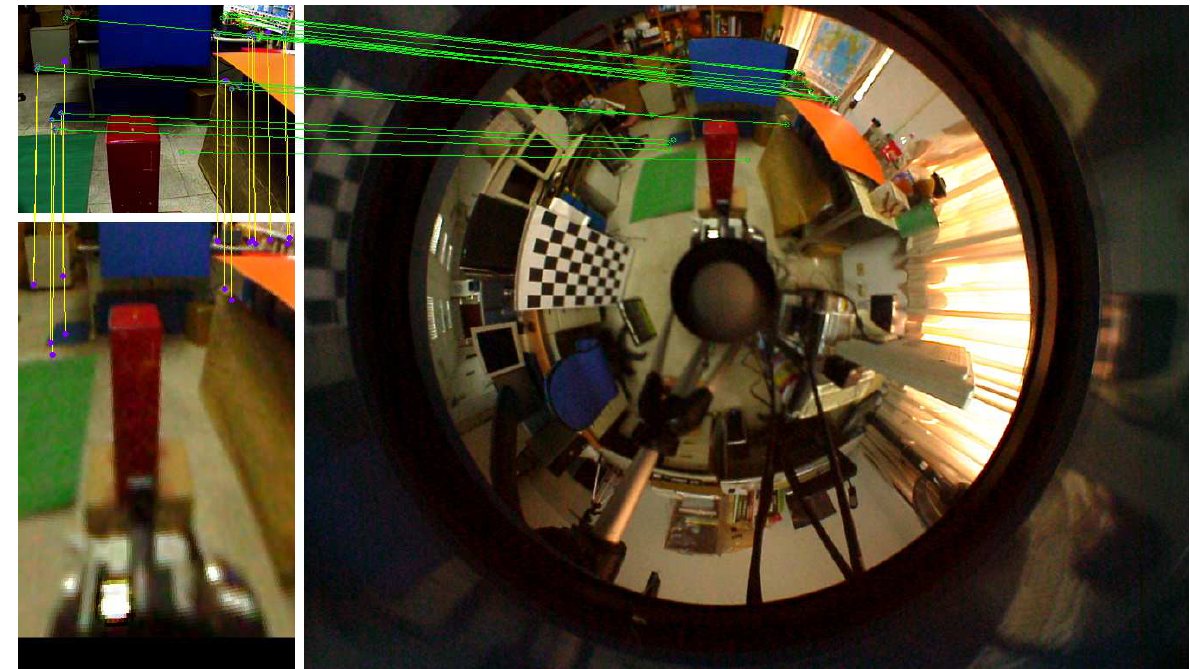
Figure 4. The omnidirectional and perspective images captured in a real-world scene. The green lines indicate the correspondences of SIFT features via direct matching. The yellow lines represent the correspondence matching between the perspective and virtual images. The result shows that the feature matching on the virtual-perspective image pair is better than the direct matching on the omnidirectional-perspective image